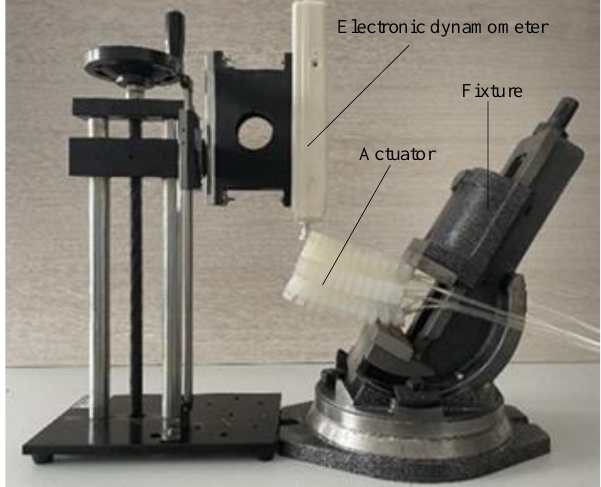
Figure 14. Driving moment measurement of hexagonal prism soft-bodied bionic actuator.